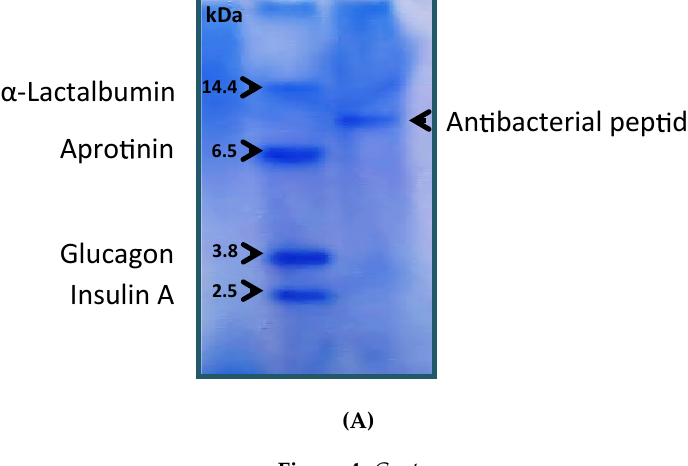
Figure 3. Stability of antibacterial peptide production from Saccharomyces cerevisiae under different pH and temperature